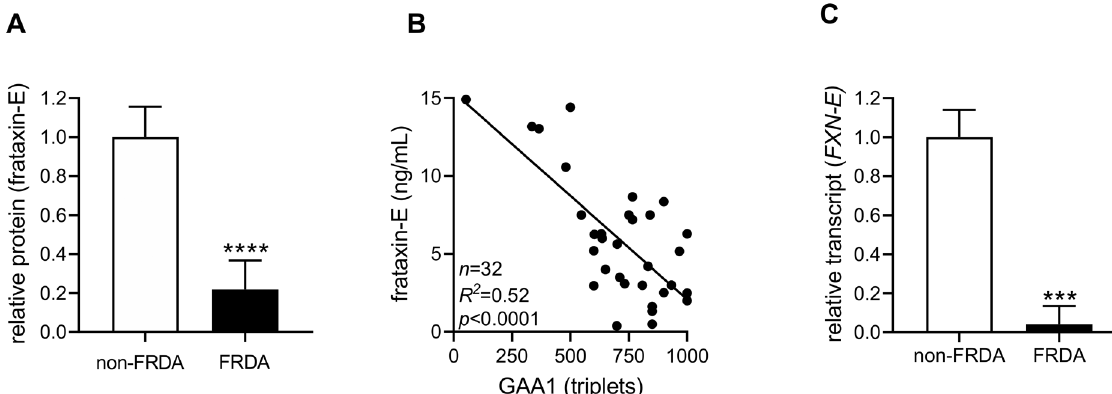
Figure 3. Deficiency of frataxin-E correlates with the length of the expanded GAA triplet repeat. ( A ) Frataxin-E protein in erythrocytes is deficient in FRDA (FRDA [n = 32] vs non-FRDA [n = 11]; mean ± SD; two-tailed unpaired t test, p < 0.0001, t = 14.86, df = 41). ( B ) Frataxin E protein is inversely correlated with the shorter of the two expanded GAA alleles (GAA1) in FRDA. ( C ) Deficiency of FXN-E transcript in FRDA lymphoblastoid cells (FRDA [n = 4] vs non-FRDA [n = 2]; mean ± SD; two-tailed, unpaired t test, p = 0.0001, t = 10.98, df =